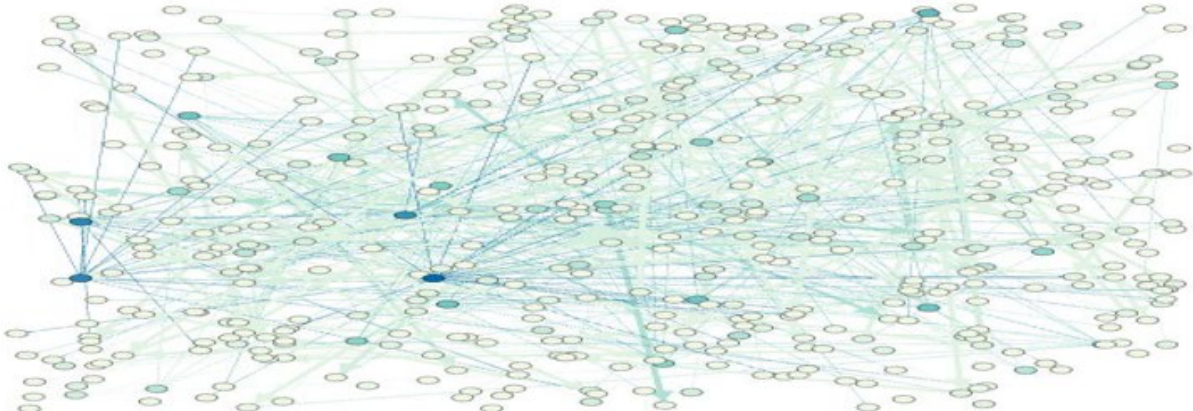
Figure 11. Graphs of messages without categories according to their repercussion